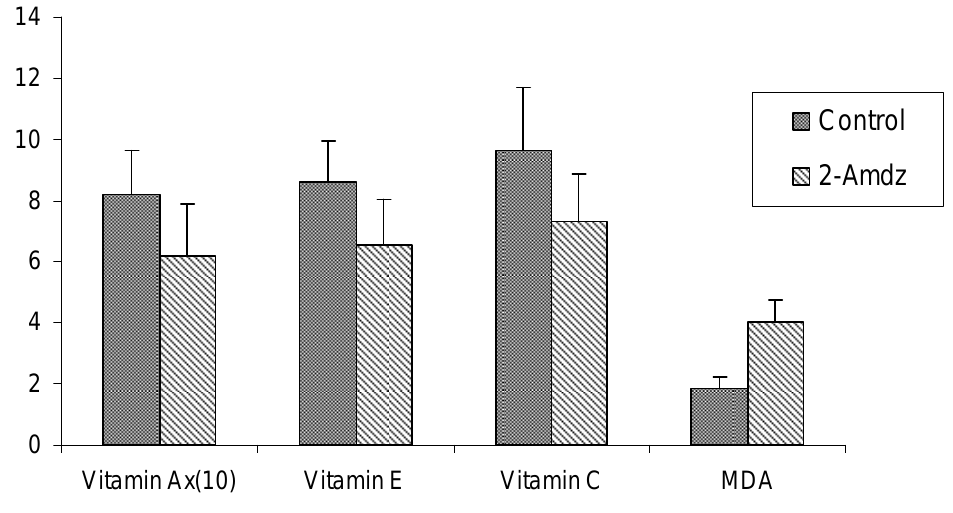
Figure 1. Comparisons of the serum levels of vitamins A, E and C and MDA between rats injected with 2-Amdz and the control